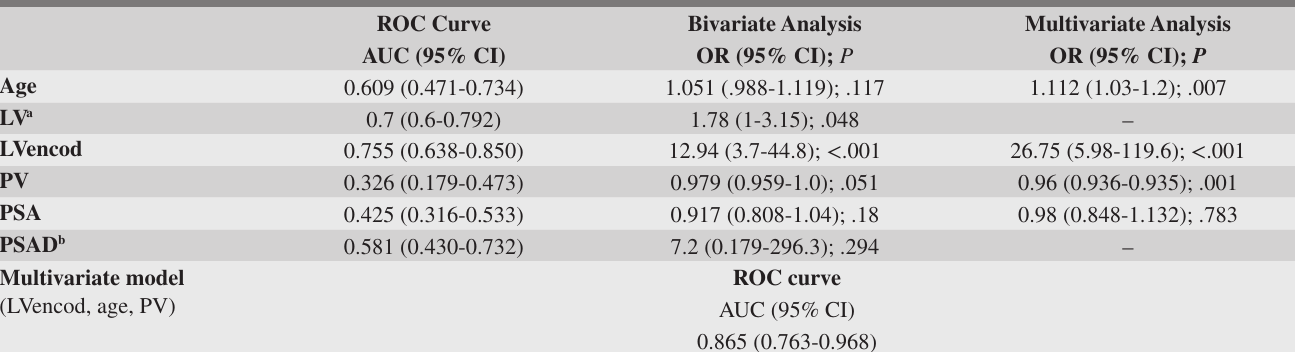
Table 4. ROC curves of individual predictor variables in bivariate and multivariate analysis. ROC